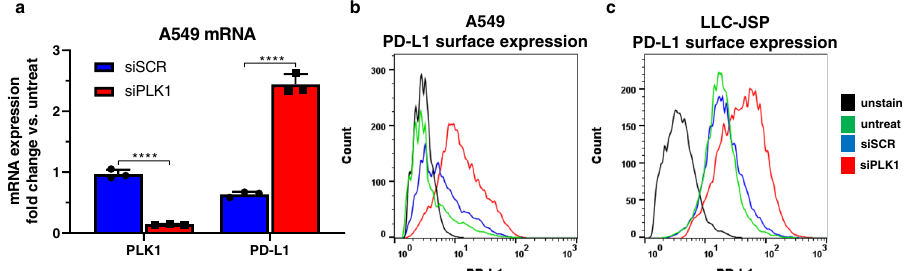
Fig. 1 PLK1 knockdown by siRNA induces PD-L1 expression. a PLK1 and PD-L1 mRNA expression in A549 (human NSCLC) at 48 h post treatment with PLK1 siRNA (siPLK1) or scrambled siRNA (siSCR) normalized to HPRT housekeeping gene. Dharmafect 1 transfection agent was used. Data presented as mean ± SD from 3 independent samples; **** P < 0.0001 (Unpaired t -test; two-tailed). PD-L1 surface expression of ( b ) A549 and ( c ) LLC-JSP at 72 h post treatments assessed by fl ow cytometry. Data presented as histogram of individual events (cells); **** P < 0.0001 for A549 siPLK1 vs. untreat; **** P < 0.0001 for LLC-JSP siPLK1 vs. untreat (Unpaired t -test; two-tailed). Source data are provided as a Source Data fi